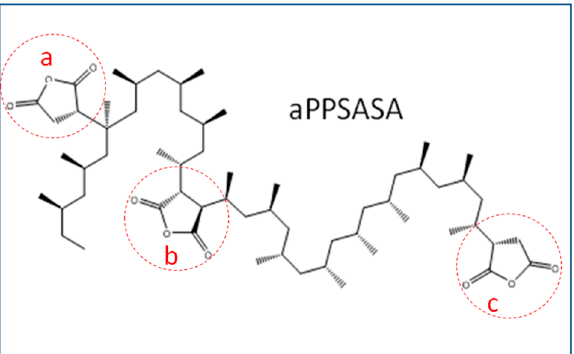
Figure 1. Waste origin interfacial agent containing side (a), bridge (b), and terminal grafts (c) onto atactic polypropylene chains.